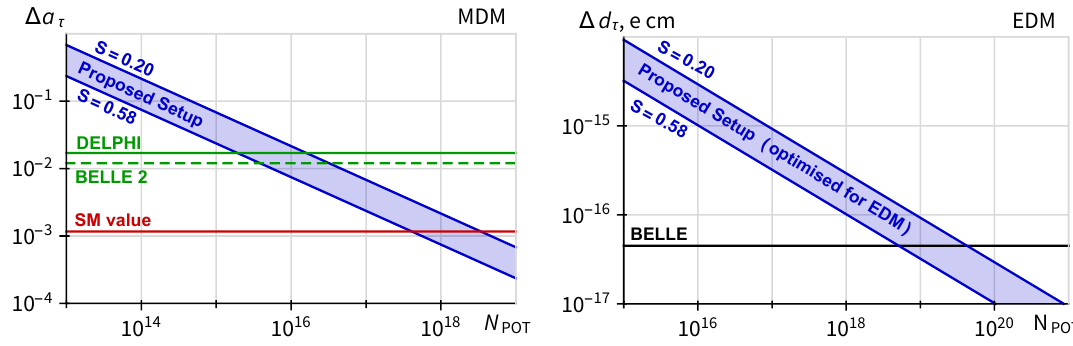
Figure 10 . Absolute statistical error (left) of the anomalous MDM, (right) of EDM of the (cid:28) lepton.